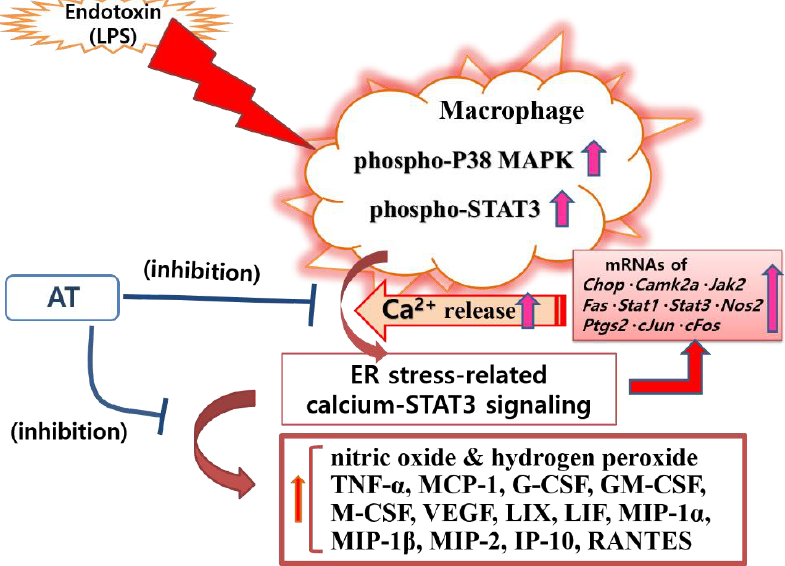
Figure 7. A schematic diagram of the inhibitory effect of Angelica tenuissima root (AT) on endotoxins- activated RAW 264.7 via the calcium – STAT3 pathway.